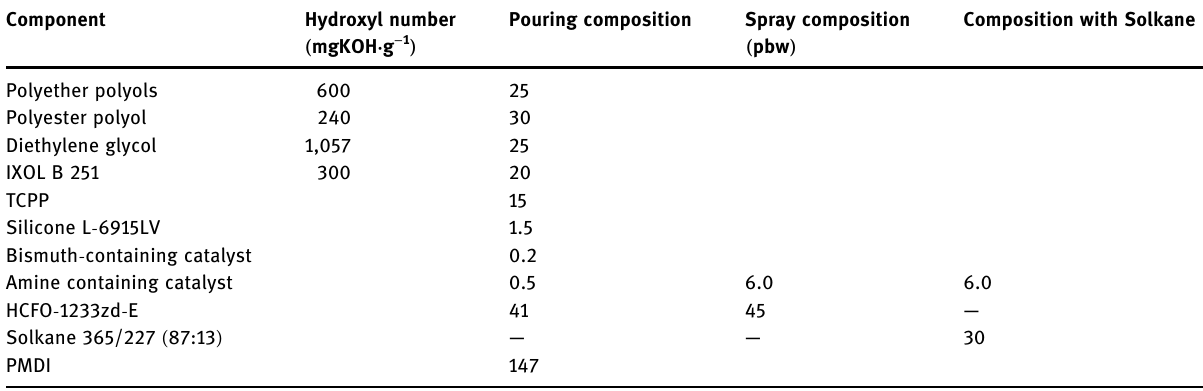
Table 1: Low - density PUR foams formulations in pbw ( parts by weight )